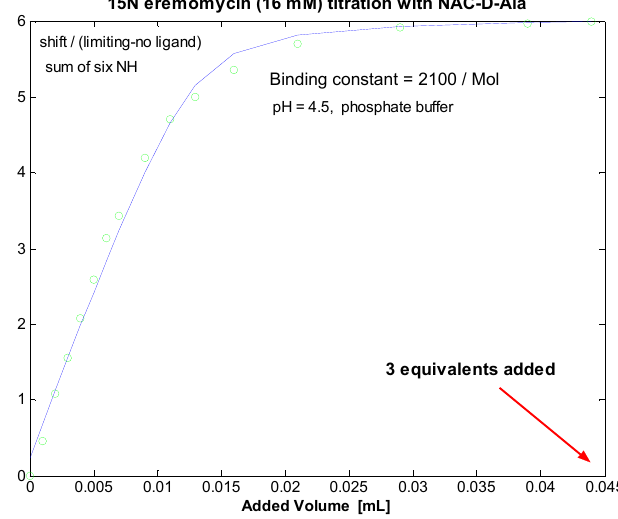
Figure 7. Chemical shift titration of dimeric 15 N-labelled eremomycin with N -Ac- D -Ala.